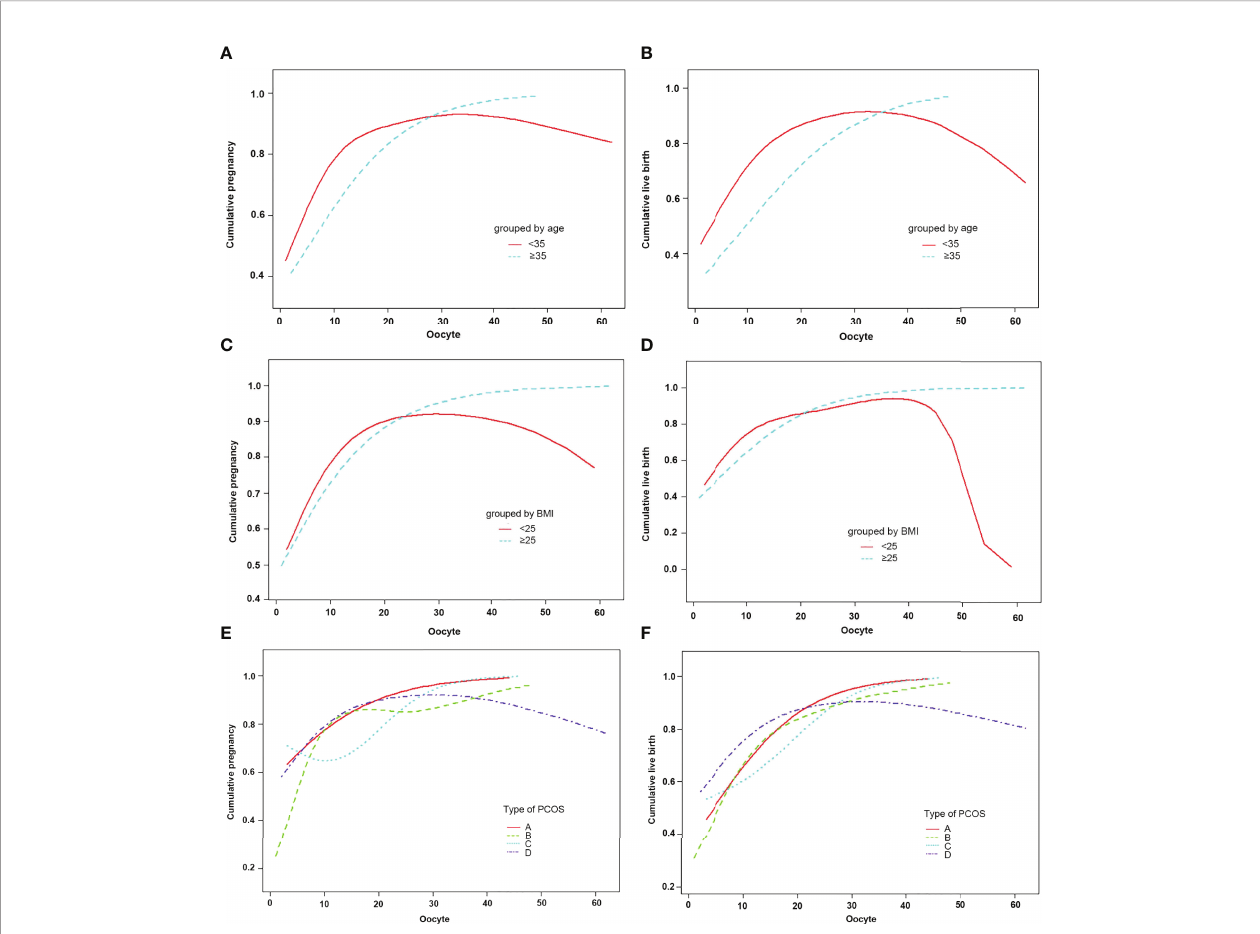
FIGURE 3 | Patients were classi fi ed according to age, BMI, type of PCOS strati fi cation, curve fi tting between the number of oocytes retrieved, and cumulative clinical outcomes. The adjusted smoothed plots between the number of oocytes retrieved with the cumulative pregnancy rate and the cumulative live birth rate are based on a piecewise regression model (A – F) . In (A, B) , the red line represents the age less than 35 years old, and the blue line represents the age greater than or equal to 35 years old. In (C, D) , the red line represents the BMI of less than 25, and the blue line represents the BMI of greater than or equal to 25. In (E, F) , the red line represents the phenotype A, the green line represents the phenotype B, the blue line represents the phenotype C, and the purple line represents the phenotype D. Adjustment factors included age, BMI, bFSH, bE2, dose of Gn, type of PCOS, years of infertility, cycle outcome, and if not strati fi ed.